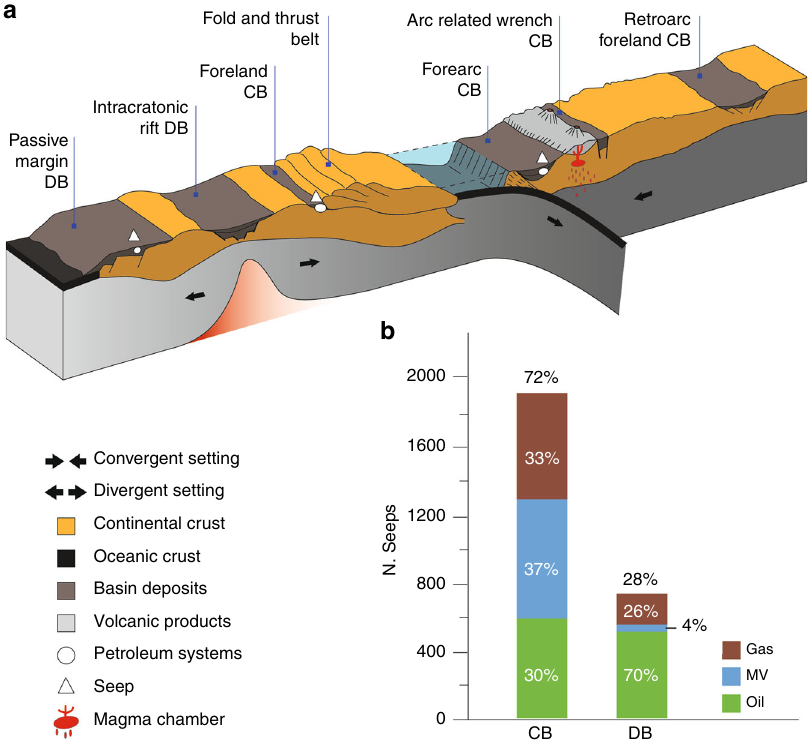
Fig. 1 Simpli fi ed conceptual geological model of convergent and divergent geodynamic settings. a The main basin typologies and the potential occurrence of petroleum systems and seeps are also indicated. b Bar plot of seeps distribution: gas seeps, mud volcanoes (MV) and oil seeps, in convergent (CB) and divergent (DB) basins.